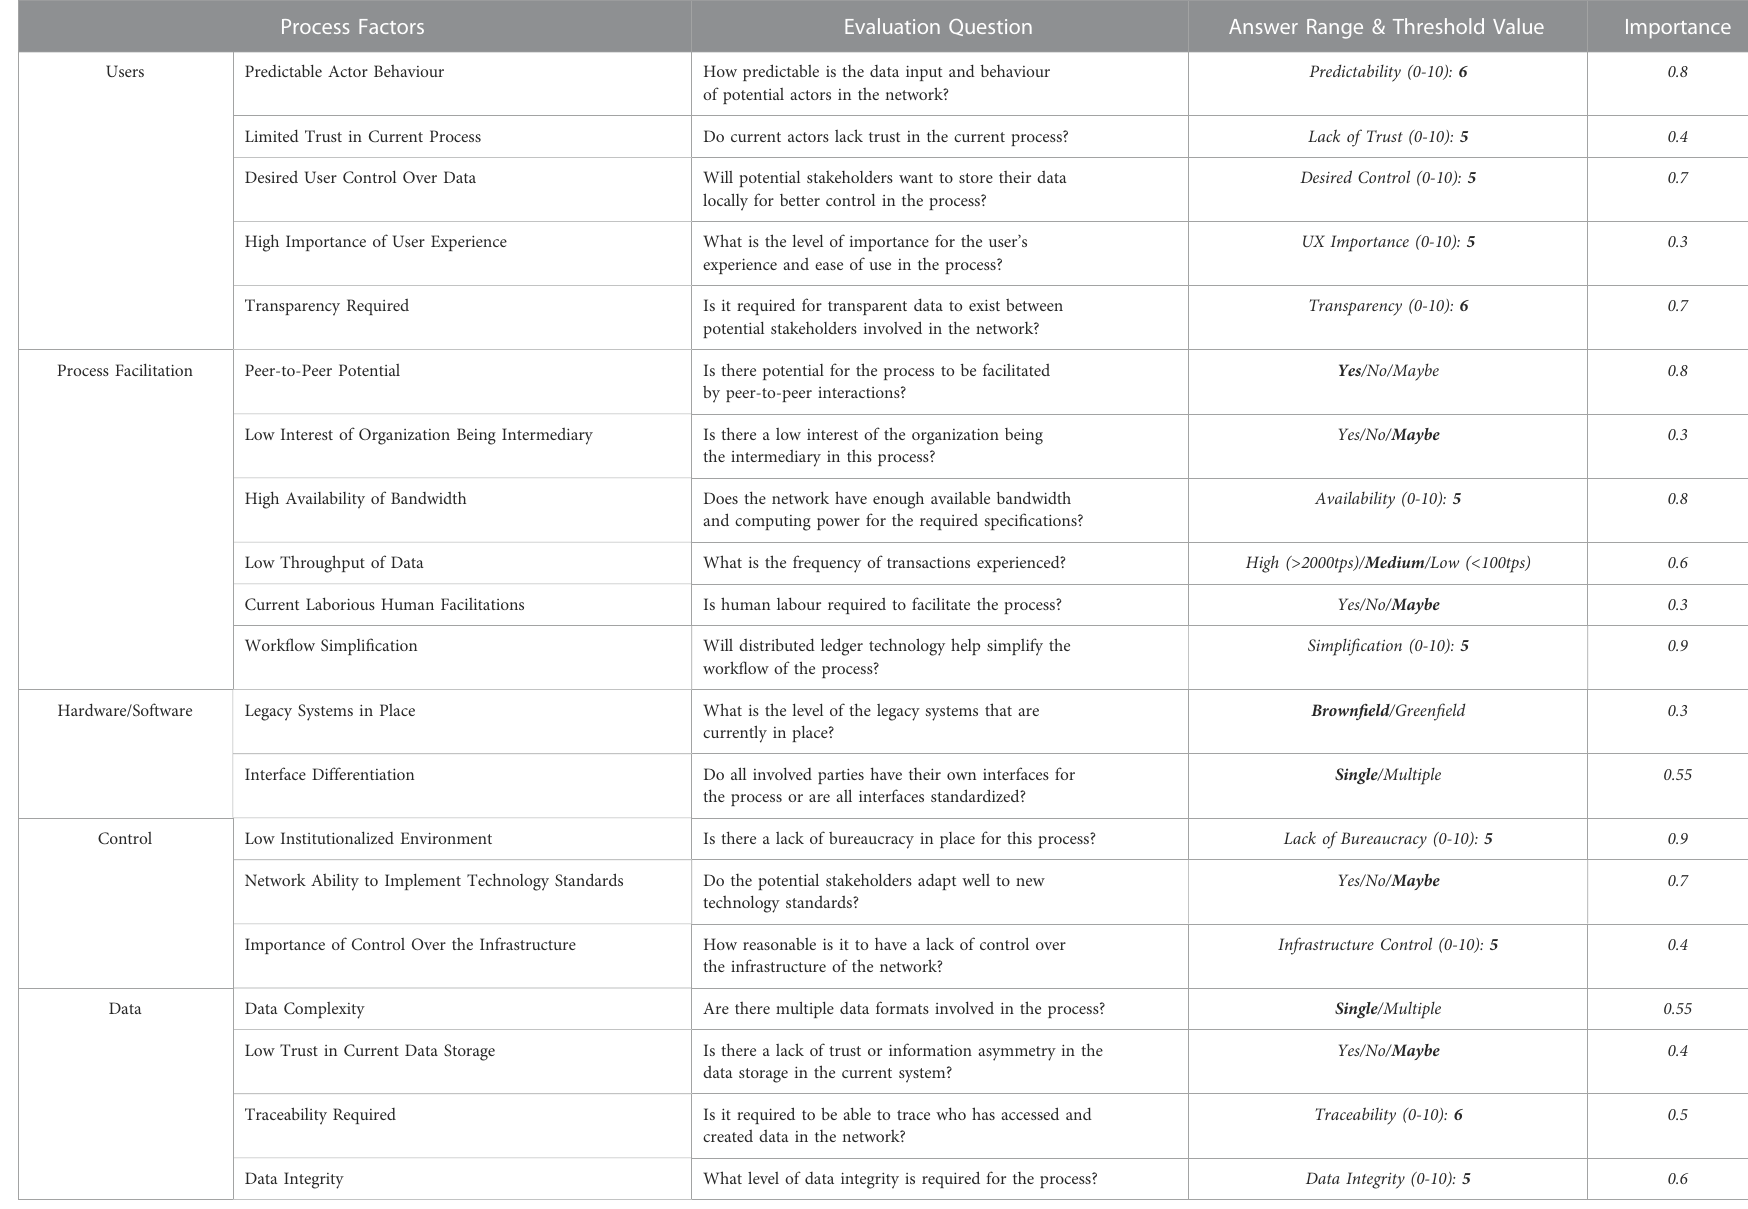
TABLE 3 Process Factor Evaluation